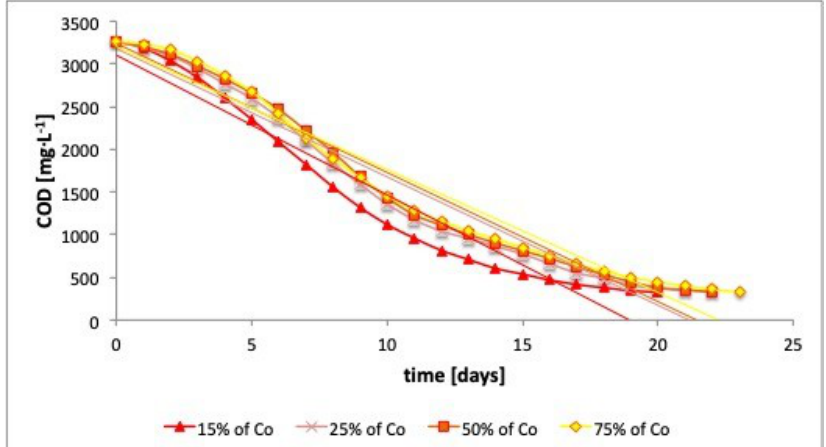
Figure 3. Reduction in chemical oxygen demand (COD) concentration resulting from the operation of our cathode designs with various compositions (15, 25, 50, and 75% Co). Colored curves mark the trend lines.